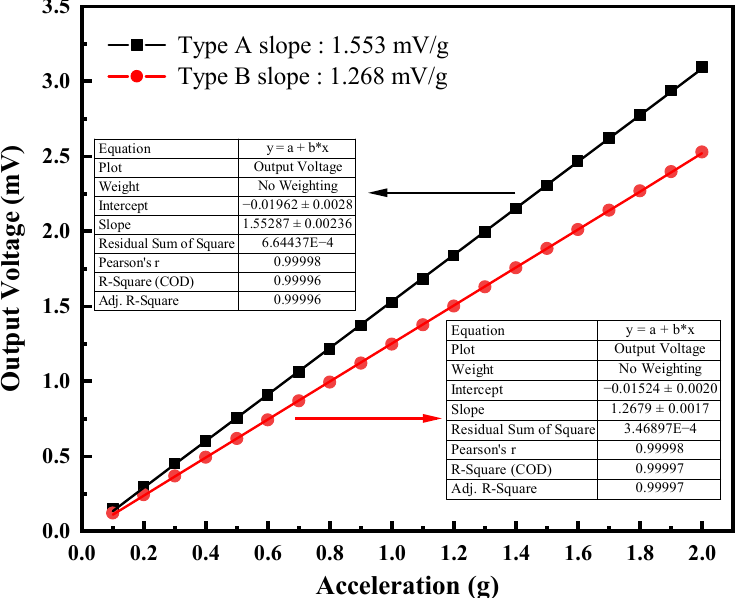
Figure 9. Output voltage vs. acceleration for Type A and Type B piezoelectric MEMS accelerometers to obtain the sensitivity and linearity at 400 Hz.